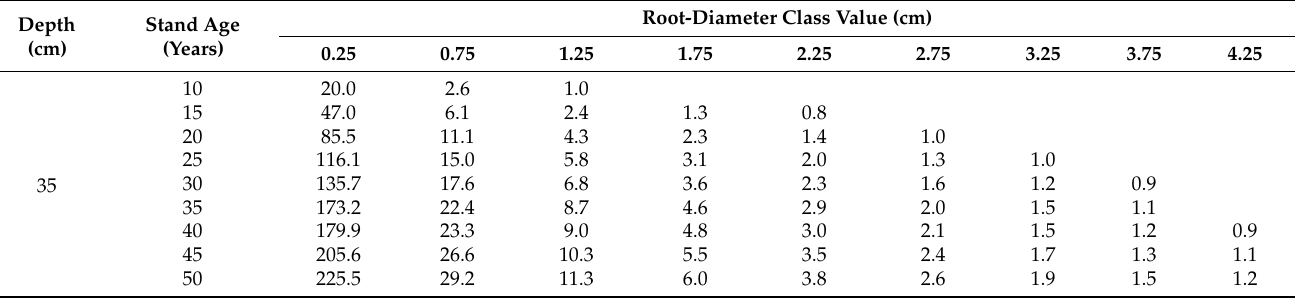
Table A1. Number of roots in each root-diameter class on a sliding surface at different depths and stand